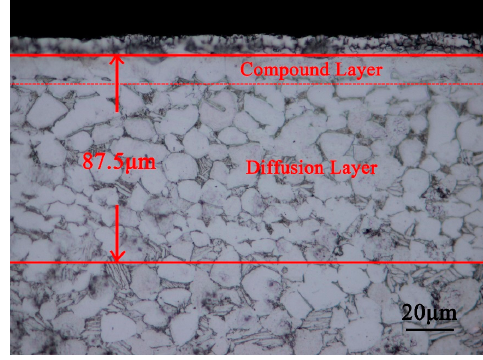
Figure 5. Cross-section microstructure of titanium alloy samples after nitriding treatment.